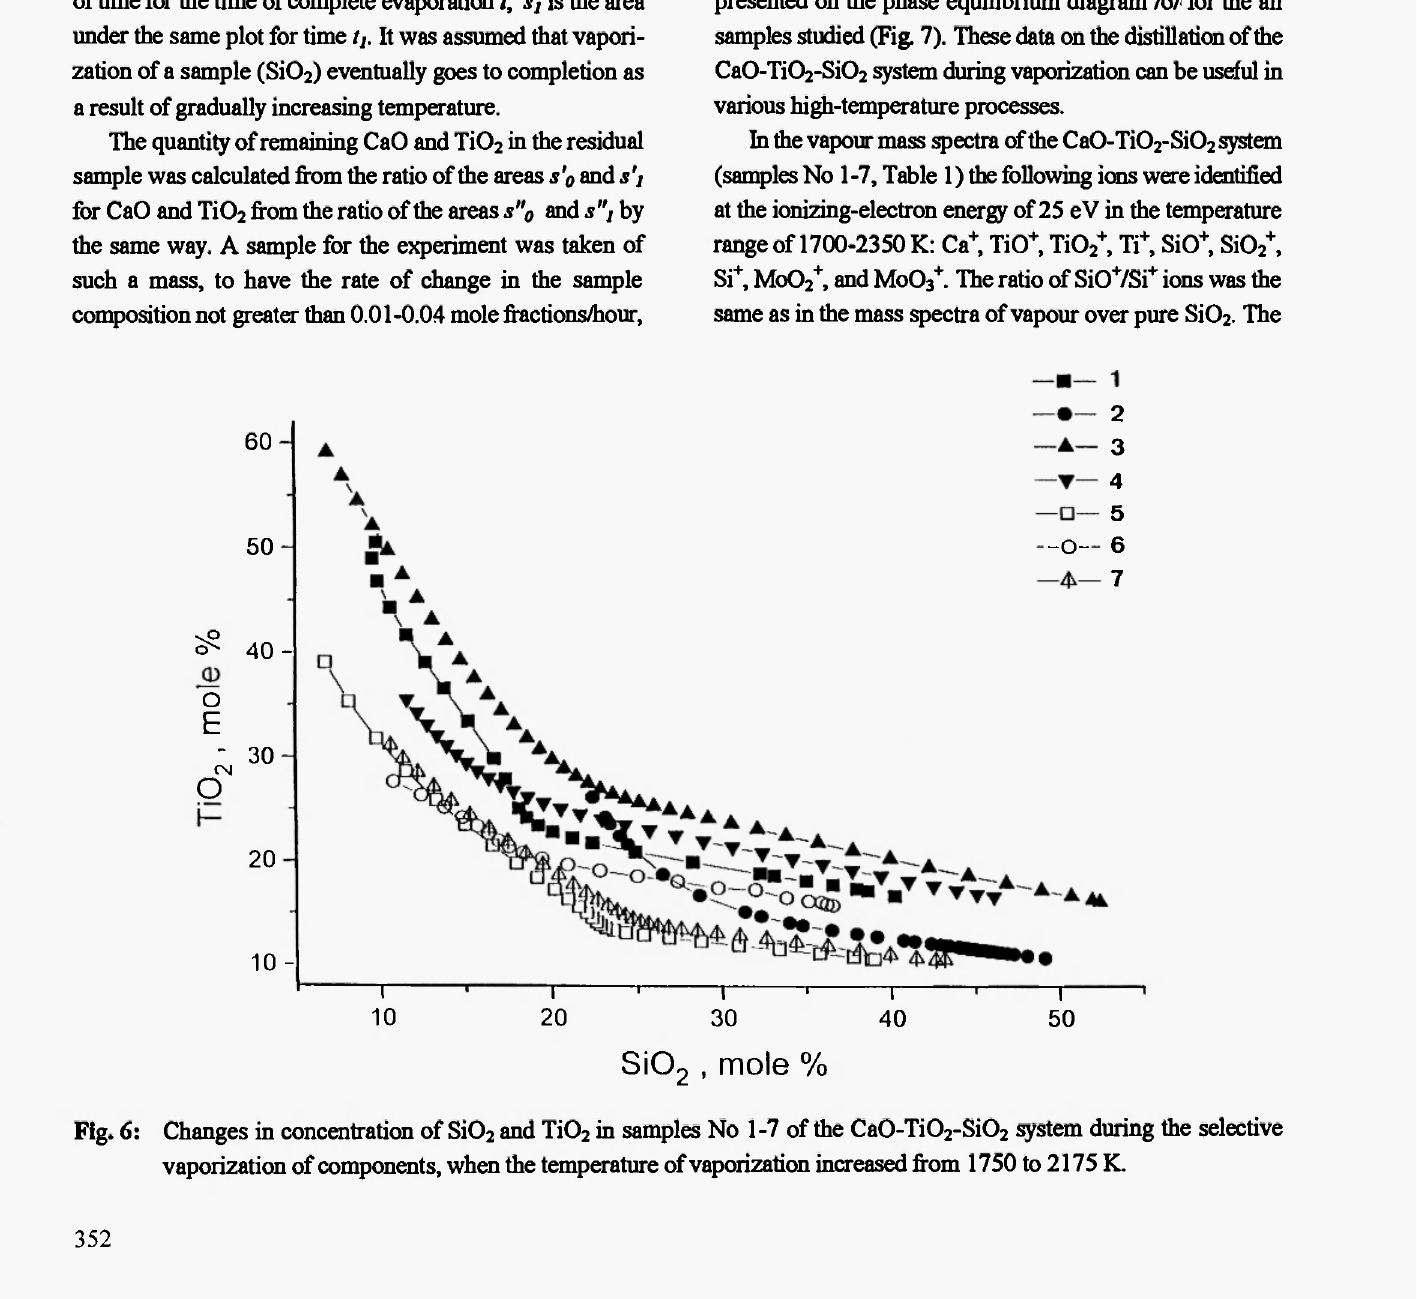
-Si0 system during the selective 2 2